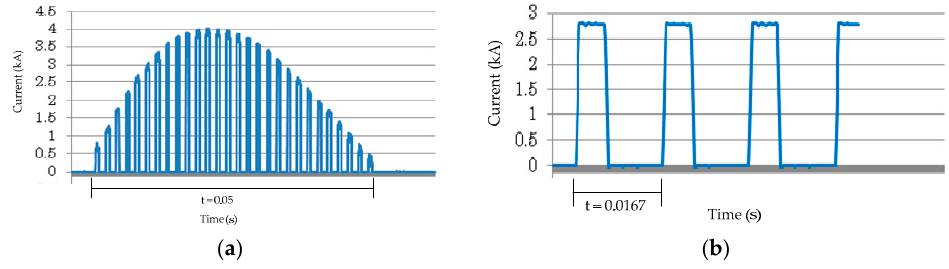
Figure 17. Thyristor current of LFAC and HVDC system: ( a ) LFAC; ( b ) HVDC.